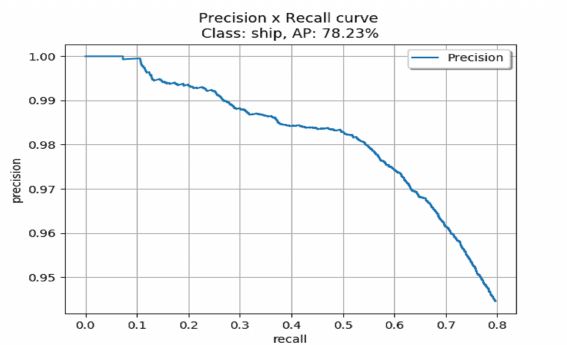
Figure 4. The Precision-Recall curve of the single frame YOLOv3